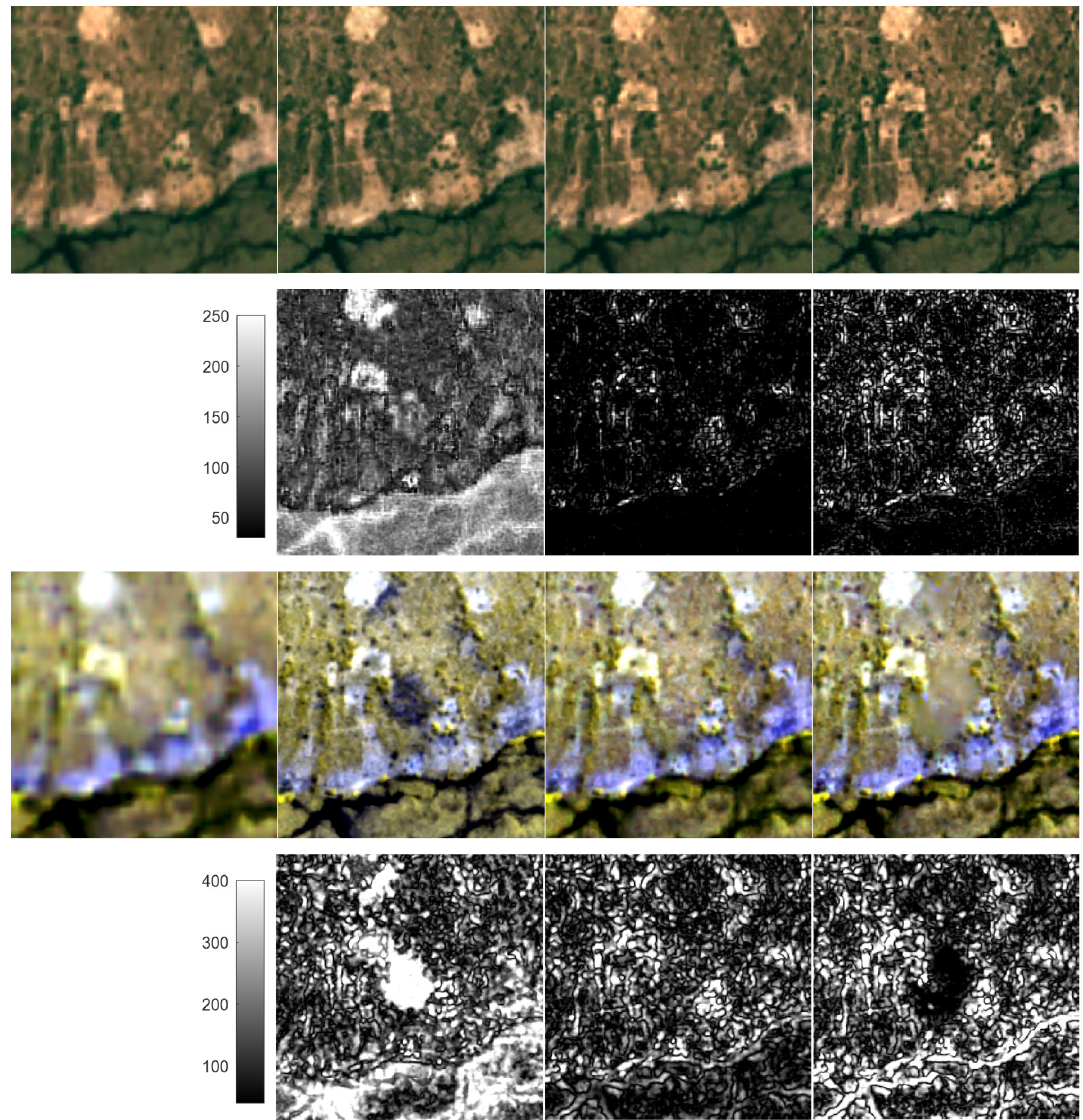
Figure 7. Study site 1 spatial subset (240 × 240 3.333 m pixels, 0.8 × 0.8 km), top row: true color (red, green, and blue) surface reflectance, third row: false color (NIR 855–875 nm, red-edge 773–793 nm, and SWIR 1565–1655 nm) surface reflectance. The columns show from left to right: Sentinel-2 surface reflectance bilinear resampled to 3.333 m, Planetscope-0 3.333 m surface reflectance, HPM sharpened 3.333 m surface reflectance, and M3 sharpened 3.333 m surface reflectance. The second and fourth rows (greyscale figures) show the root mean square di ff erence (RMSD = (cid:3495)∑ (cid:4666)𝜌 (cid:3090),(cid:3029)(cid:3036)(cid:3039)(cid:3036)(cid:3041)(cid:3032)(cid:3028)(cid:3045) (cid:3398) 𝜌 (cid:3090),(cid:3051) (cid:4667) (cid:2870)(cid:2871) (cid:3090)(cid:2880)(cid:2869) 3⁄ ) between the Sentinel-2 bilinear resampled reflectance ( ρ λ , bilinear , left column) and the Planetscope-0 derived 3.333 m, HPM, and M3 sharpened reflectance ( ρ λ , x , shown in the three right columns). RMSD values are scaled in reflectance units (0–1) multiplied by 10,000.